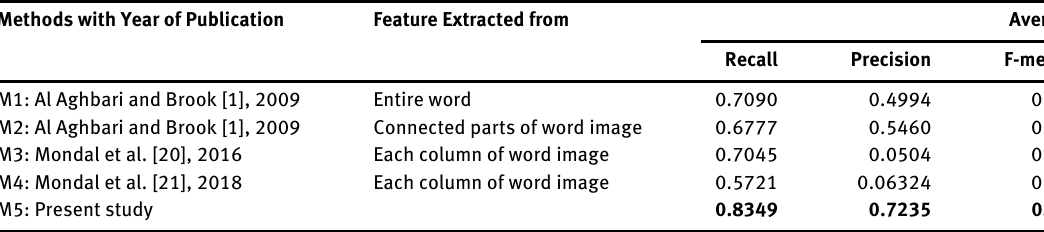
Table 5: Comparison of the Present Method with Some State-of-the-Art Word Searching Techniques. Methods with Year of Publication